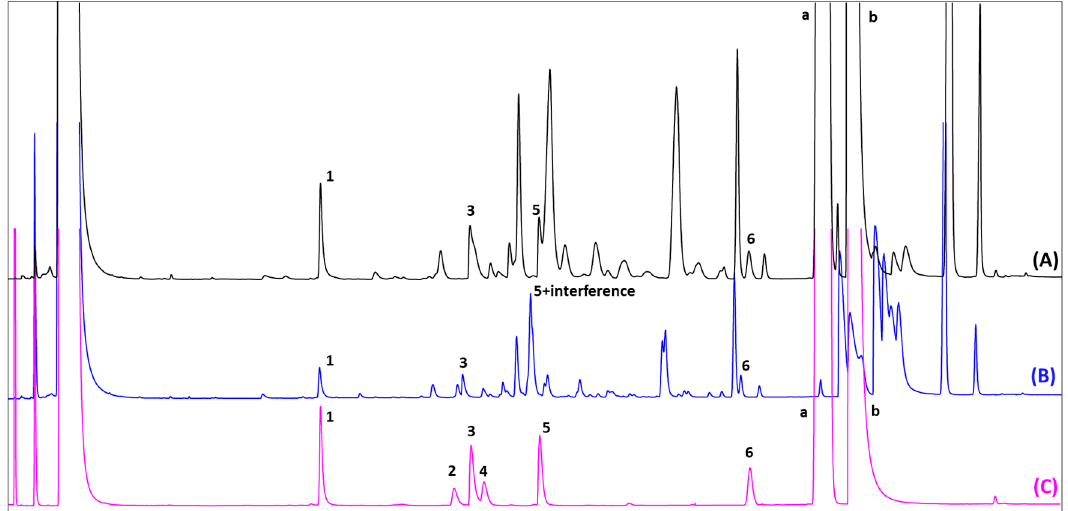
Figure 3. GC/FID profiles of ( A ) HES-based DLLME of Fragrance 1, ( B ) direct injection of Fragrance 1 and ( C ) HES-based DLLME of the reference mixture at 100 mg/L. Here, (1) linalool, (2) neral, (3) citronellol, (4) geranial, (5) geraniol, and (6) hydroxycitronellal; (a) thymol, and (b) eugenol.